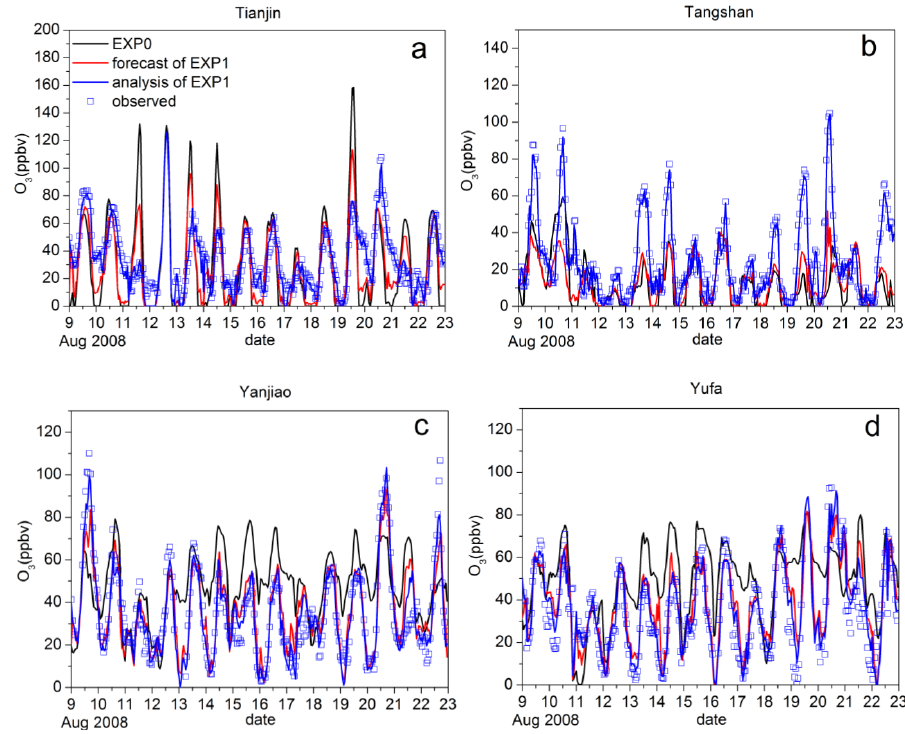
Fig. 4. Time series of the hourly ozone concentrations obtained from observation (rectangle), free run (black line), analysis (blue line) and 1-hour forecast in EXP1 (red line) at two urban sites (Tianjin and Tangshan) and at two suburban sites (Yanjiao and Yufa).